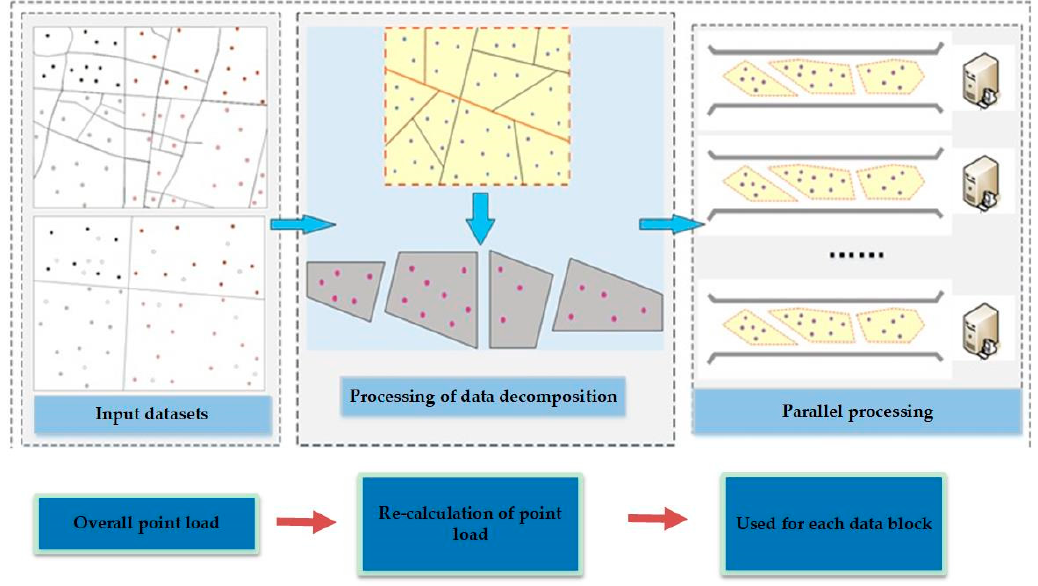
Figure 1. Impact of data decomposition on the calculation of the point load.